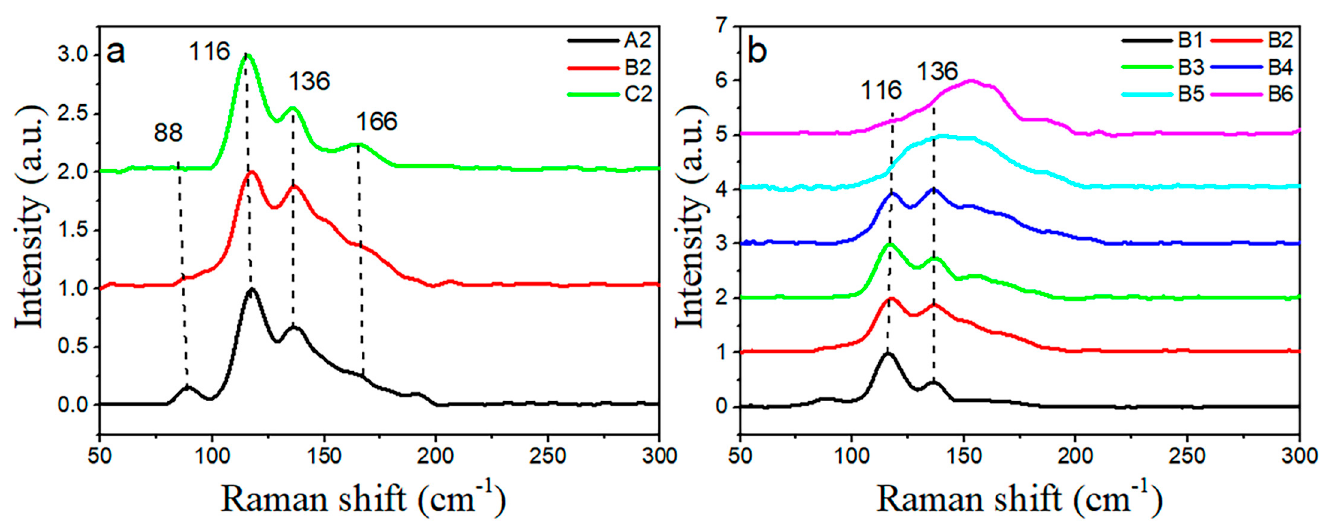
Figure 7. Raman spectra of glasses: ( a ) A2–C2: Se x (Ge 0.1 As 0.2 Te 0.7 ) 100 − x ( x = 5, 10, 14) and ( b ) B1–B6: Se 10 (Ge 0.1 As 0.9 − y Te y ) 90 ( y = 0.8, 0.7, 0.6, 0.5, 0.4, 0.3), respectively.